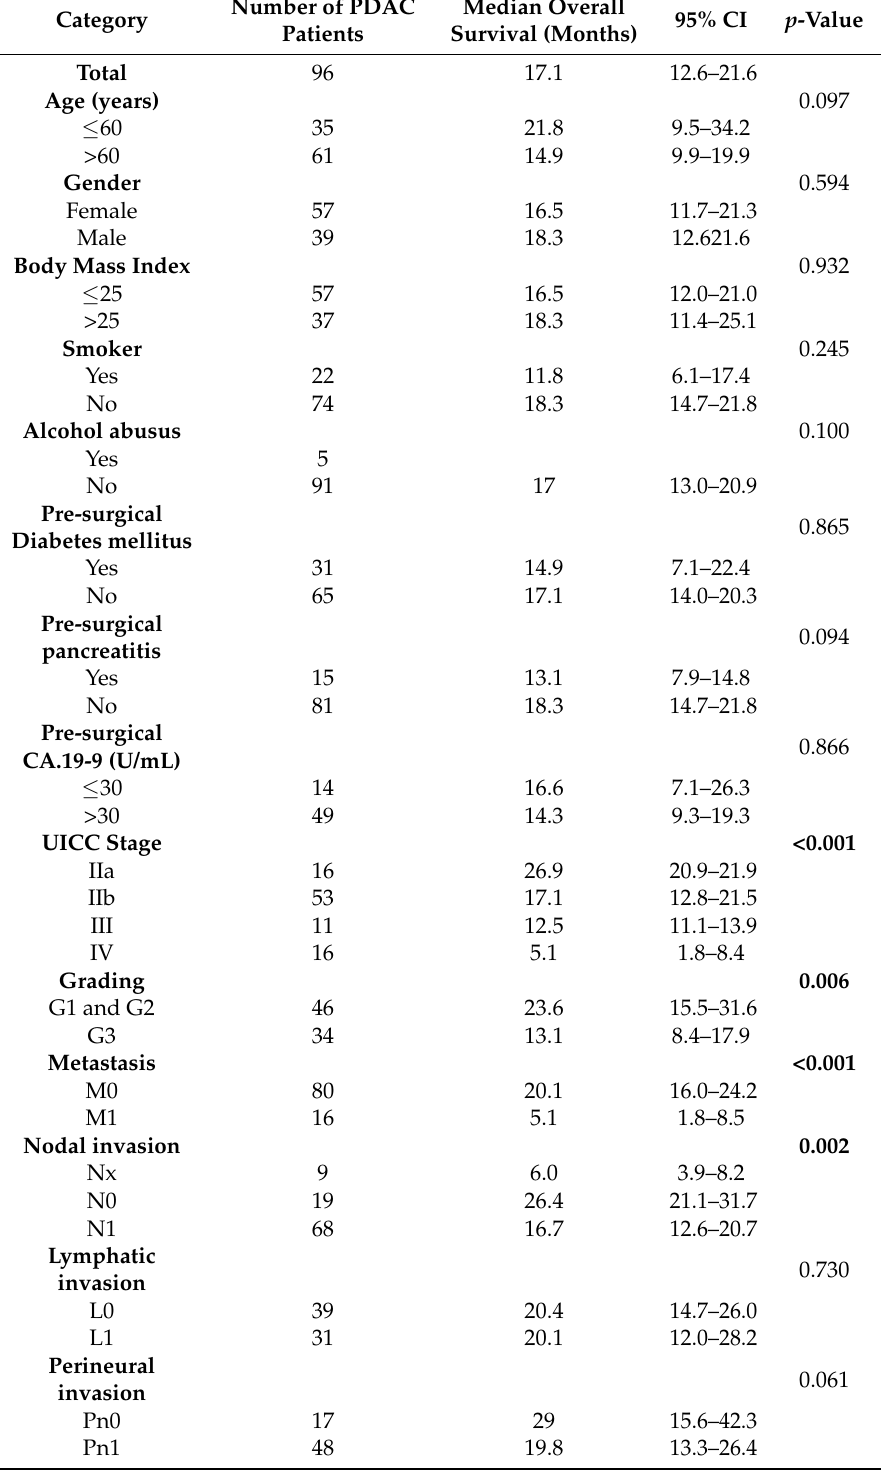
Table 1. Histopathologic characteristics of PDAC patients. Indication of median overall survival in months and 95% confidence interval (CI). p -values are calculated by Log-rank (Mantel-Cox). p ≤ 0.05 indicates